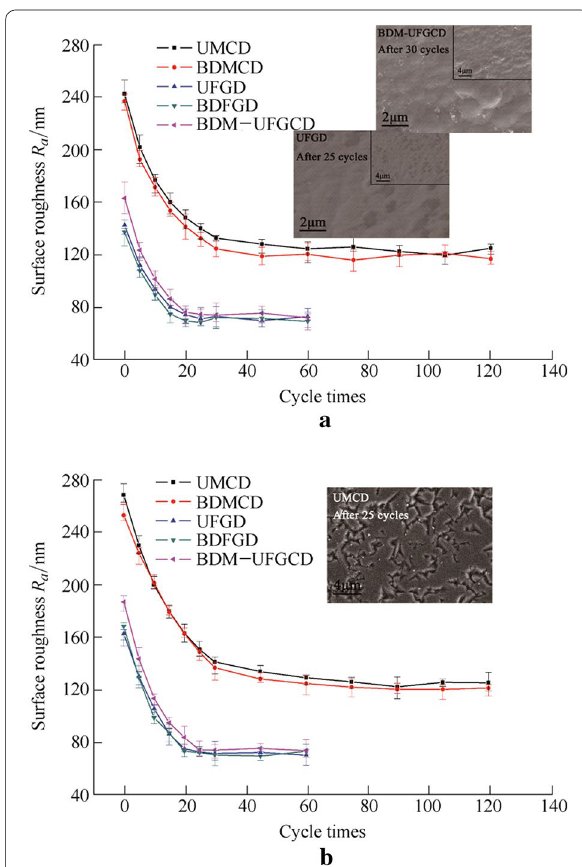
Figure 5 Variations of R a values on a the rake face and b the flank face of different diamond coated milling cutters with the cycle time, and some typical surface